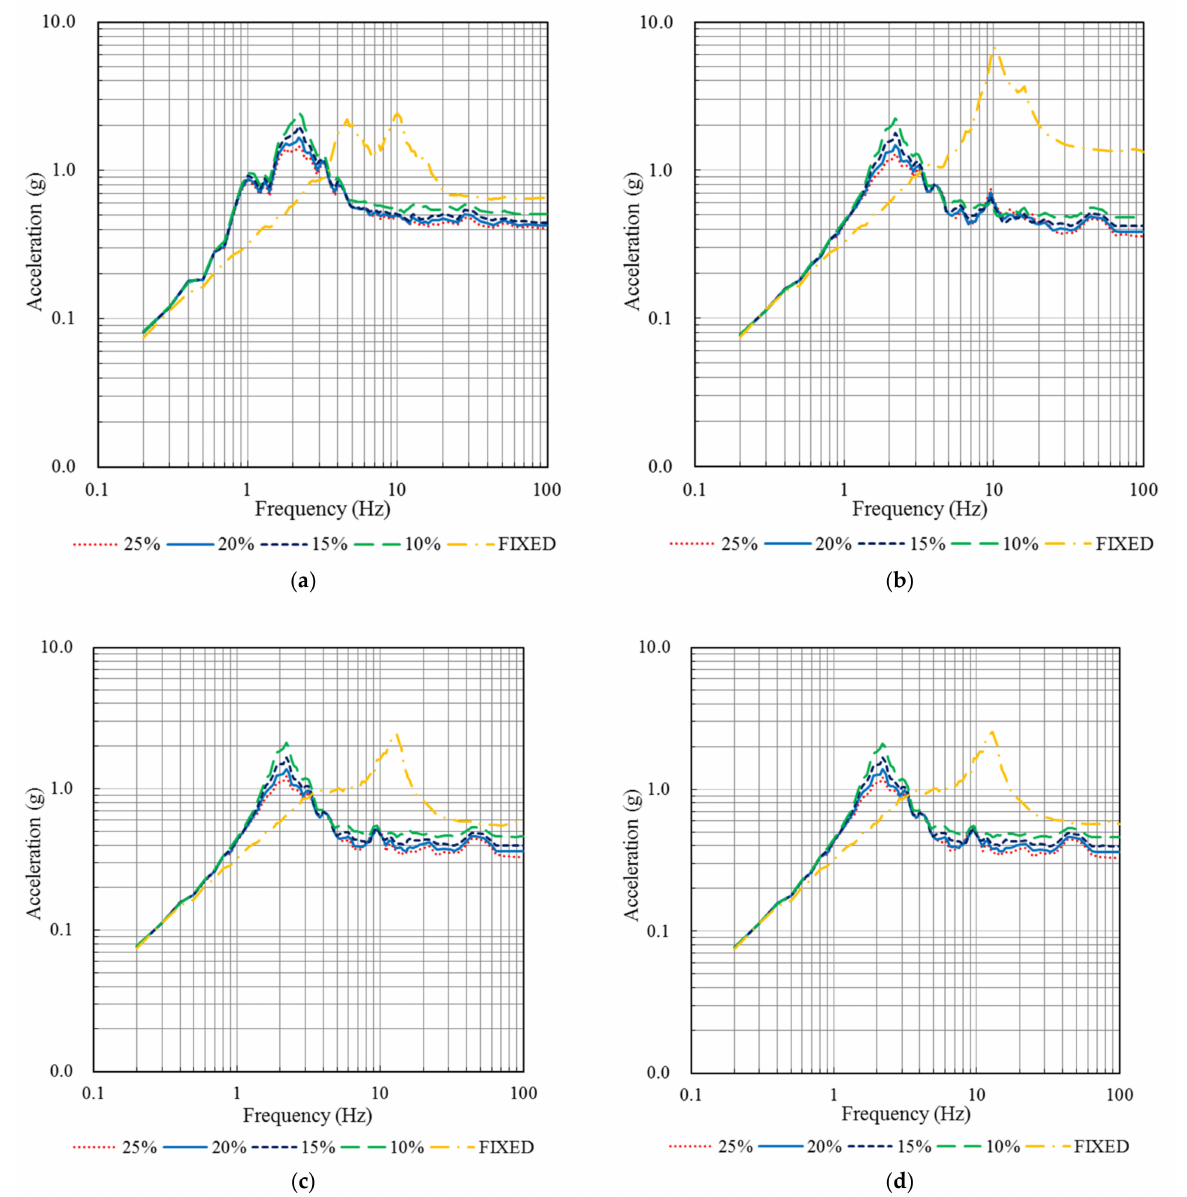
Figure 10. Comparison of the FRS of containment and internal structures in the vertical direction. ( a ) NODE 12; ( b ) NODE 13; ( c ) NODE 3; ( d ) NODE